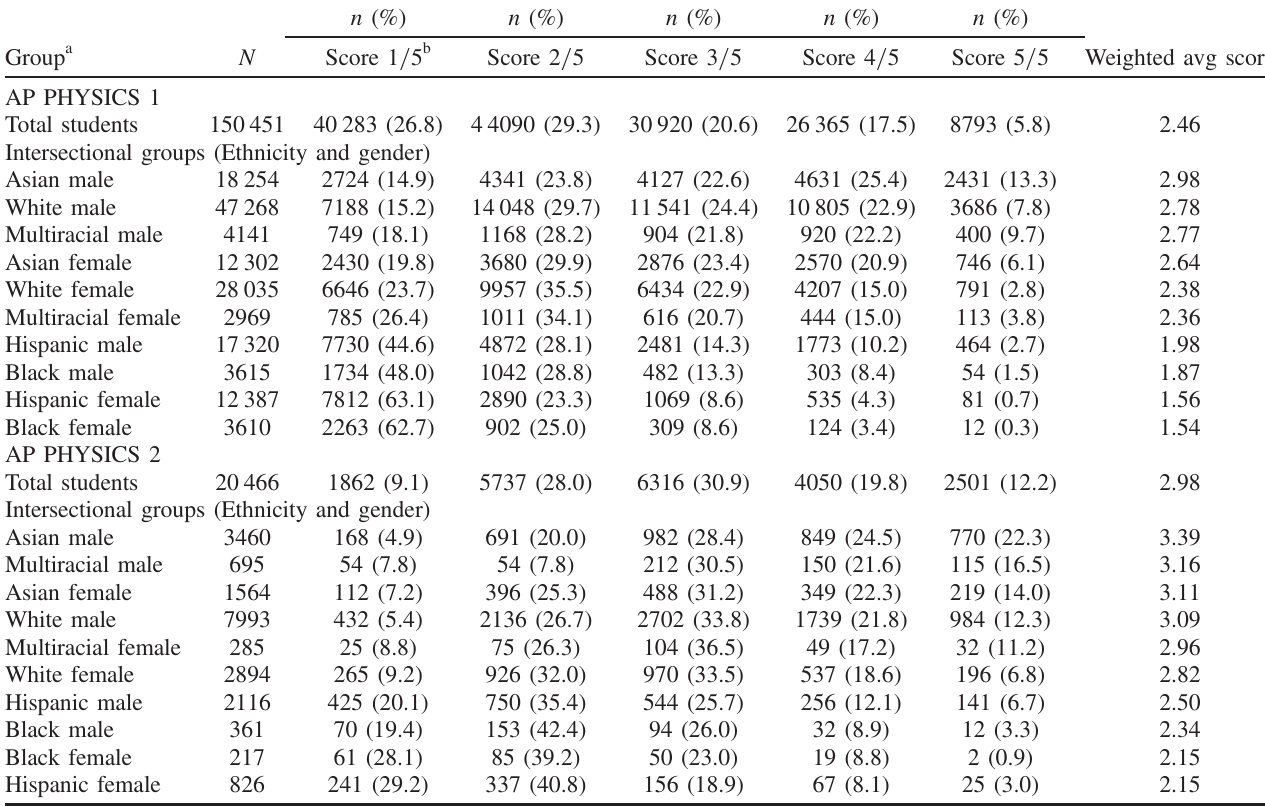
TABLE II. Score distributions in AP Physics 1 and 2, disaggregated by intersectional group and the number and percentage of students in each group earning scores 1 through 5